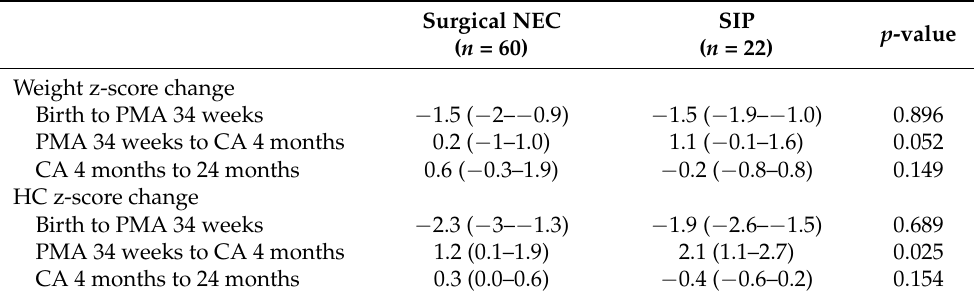
Table 3. Growth velocity of preterm infants with surgical necrotizing enterocolitis and spontaneous intestinal